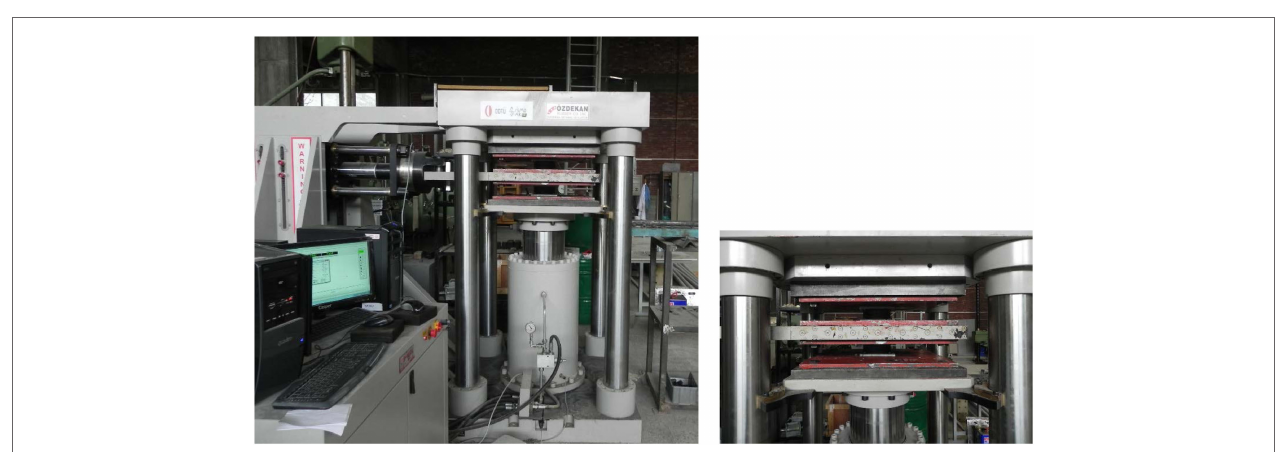
FigUre 6 | Double shear tests